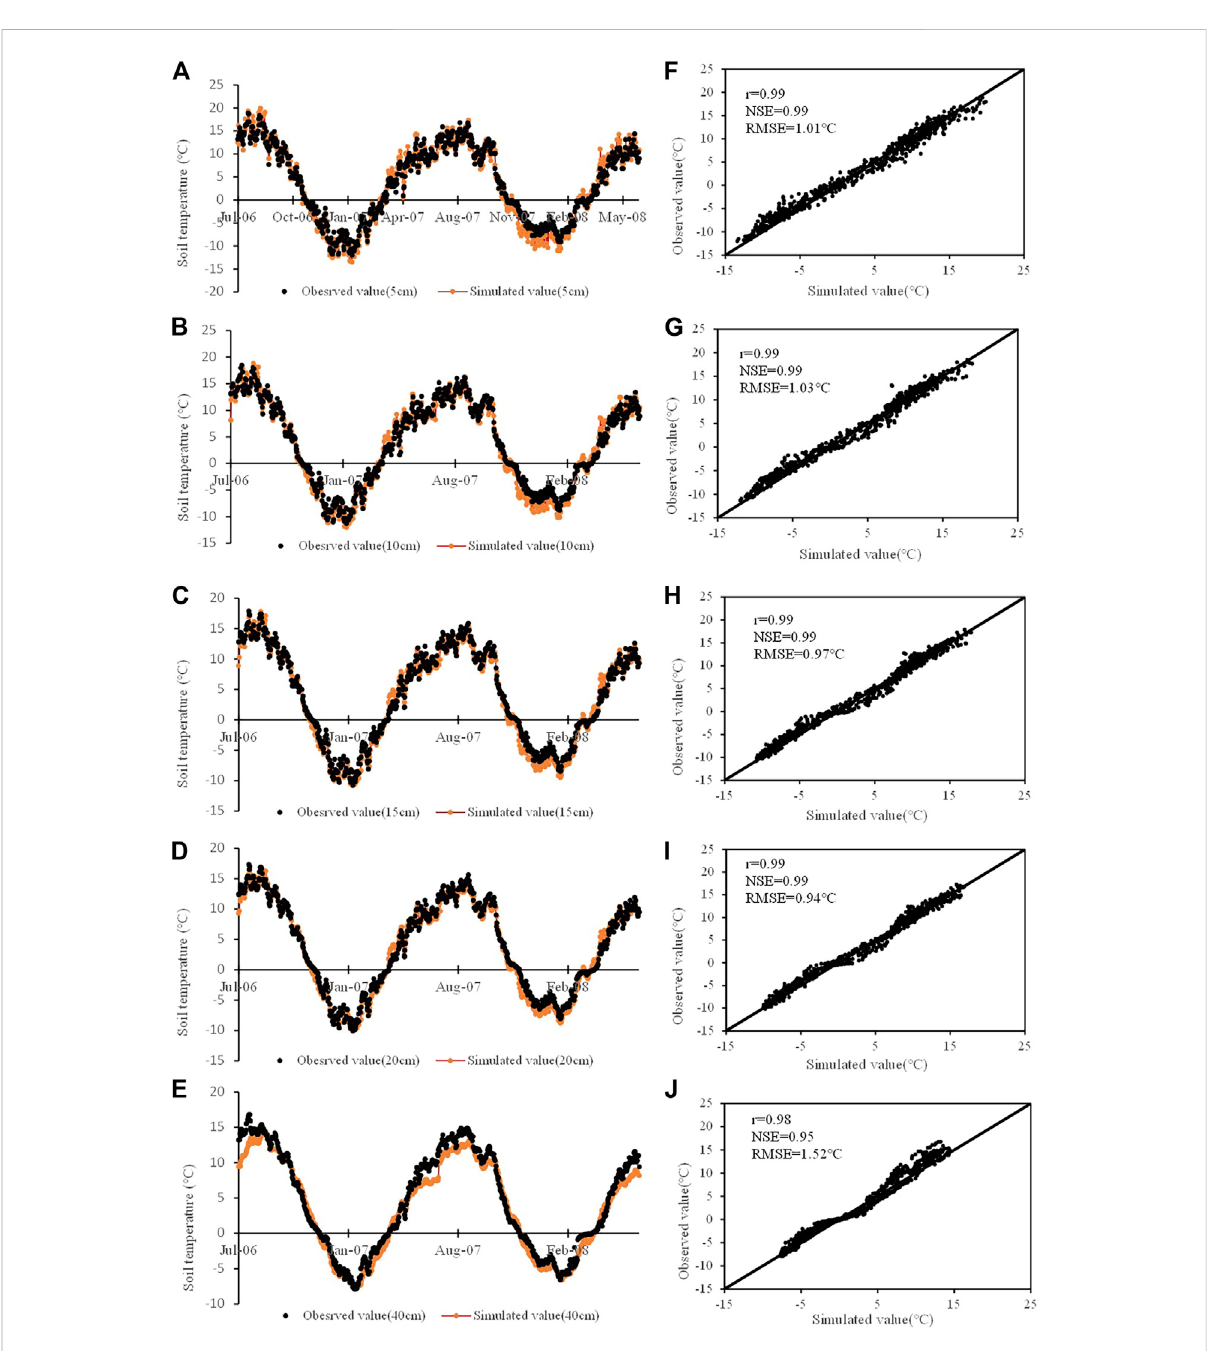
FIGURE 5 AtDarifrom1July 2006to30June 2008: (A – E) dailysoiltemperatures at5,10,15,20and40cm, (F – J) correlationbetween thesimulationand observation daily soil temperatures at 5, 10, 15, 20 and 40